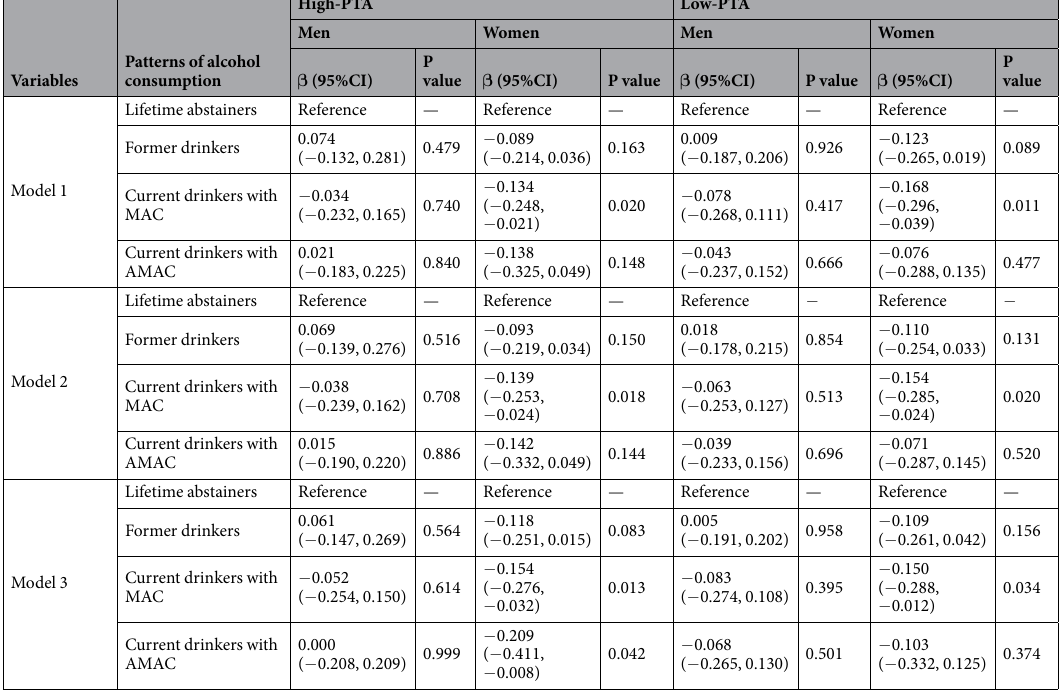
Table 3. Regression coefficients of patterns of alcohol consumption and gender for hearing threshold Adjusted covariates: Model 1 = age, sex, race. Model 2 = Model 1 + (waist circumference, uric acid, fasting glucose, total cholesterol). Model 3 = Model 2 + (abnormal otoscopy, abnormal tympanometry, present used of ototoxic agents, history of stroke, diabetes, heart disease). Definition of abbreviations: MAC = moderate alcohol consumption, AMAC = above moderate alcohol consumption, High-PTA = Pure tone average at high frequencies, Low-PTA = Pure tone average at low